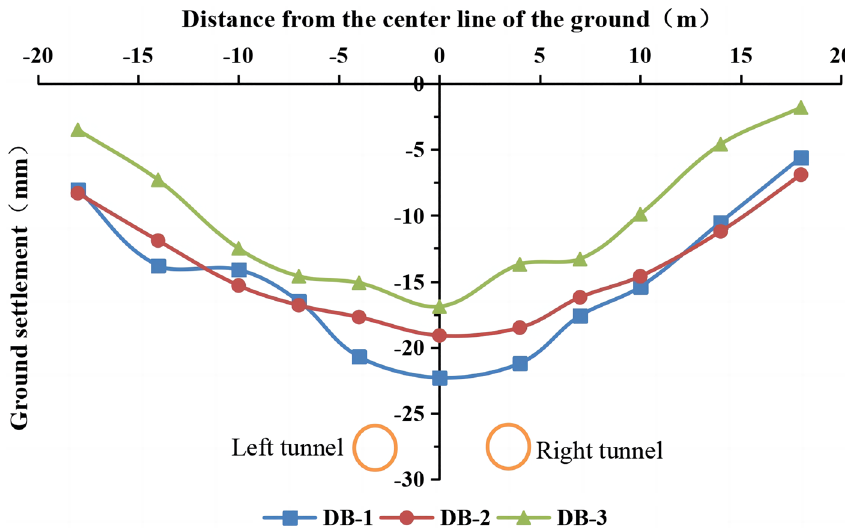
Figure 5. Measured surface settlement values after the excavation of the double-line tunnel.